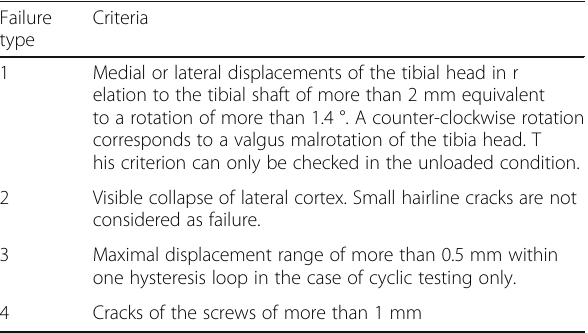
Table 3 Used failure types and their defining criteria (Diffo Kaze, 2016; Diffo Kaze et al., 2015; Maas et al.,